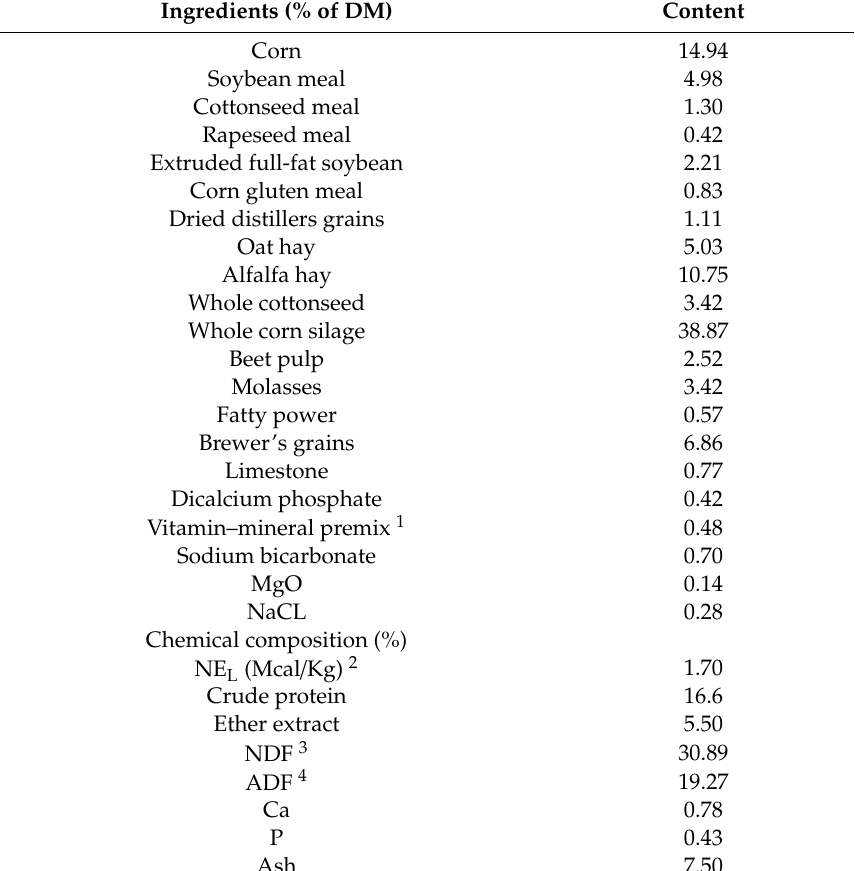
Table 2. Ingredients and chemical composition of the basal